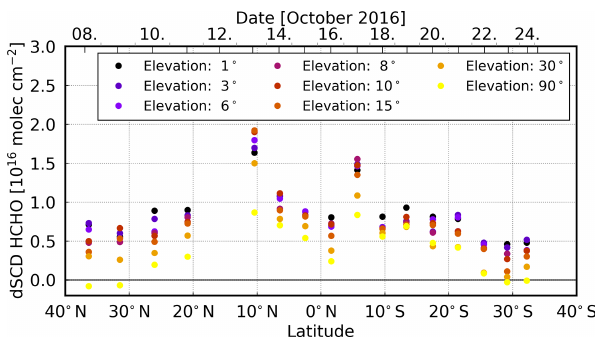
Figure 9. Daily mean HCHO dSCDs over the Atlantic Ocean over the course of the cruise (from north to south). Enhanced values in the areas of expected outflow show a different scan angle depen-